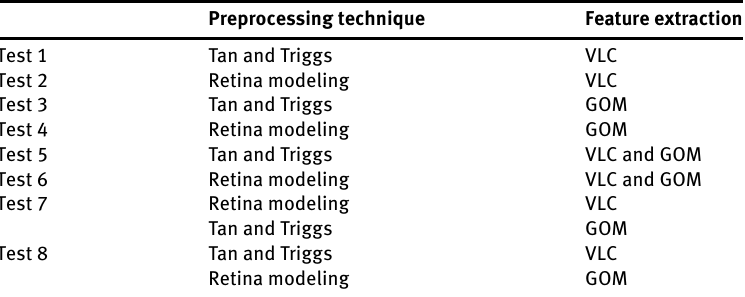
Table 1: Test Scenarios.